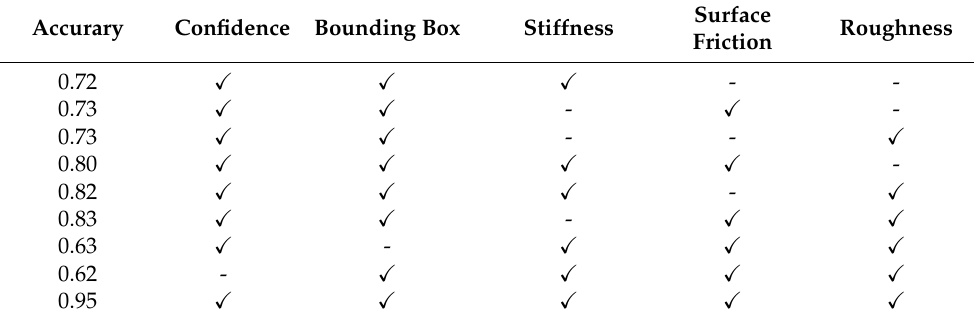
Table 2. The recognition results when using different number of features.